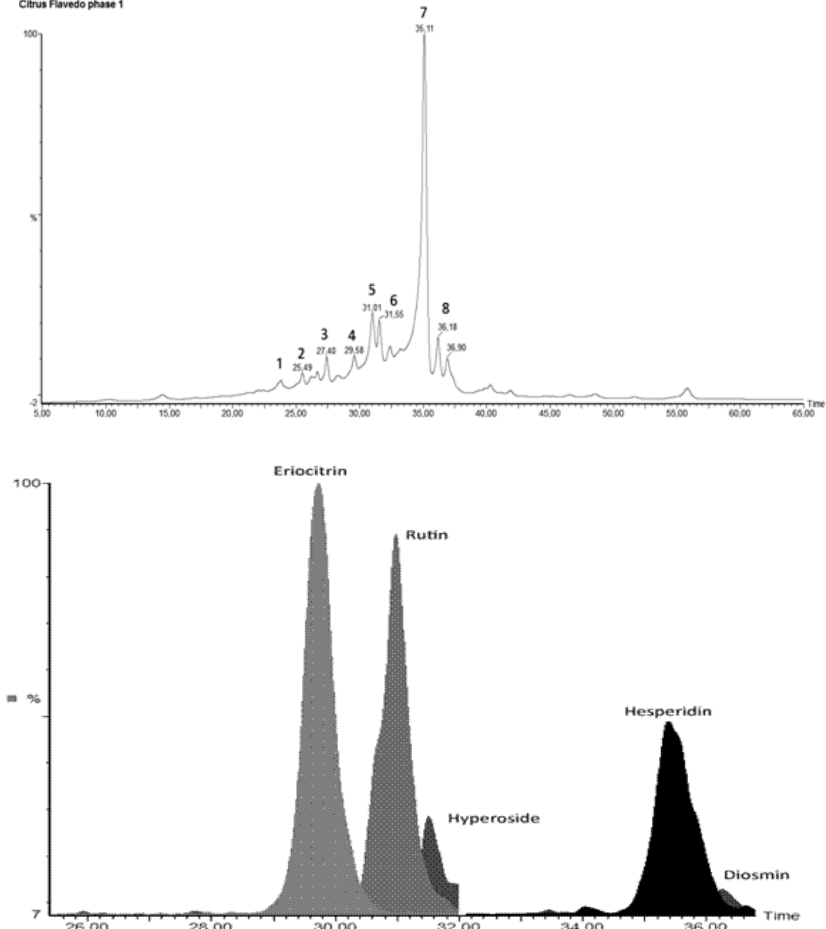
Fig. 7: Typical LC-MS/MS chromatogram of lemon peel methanolic extracts (a) and MRM chromatogram of the identified components (b) (peak assignments are given in Tab.